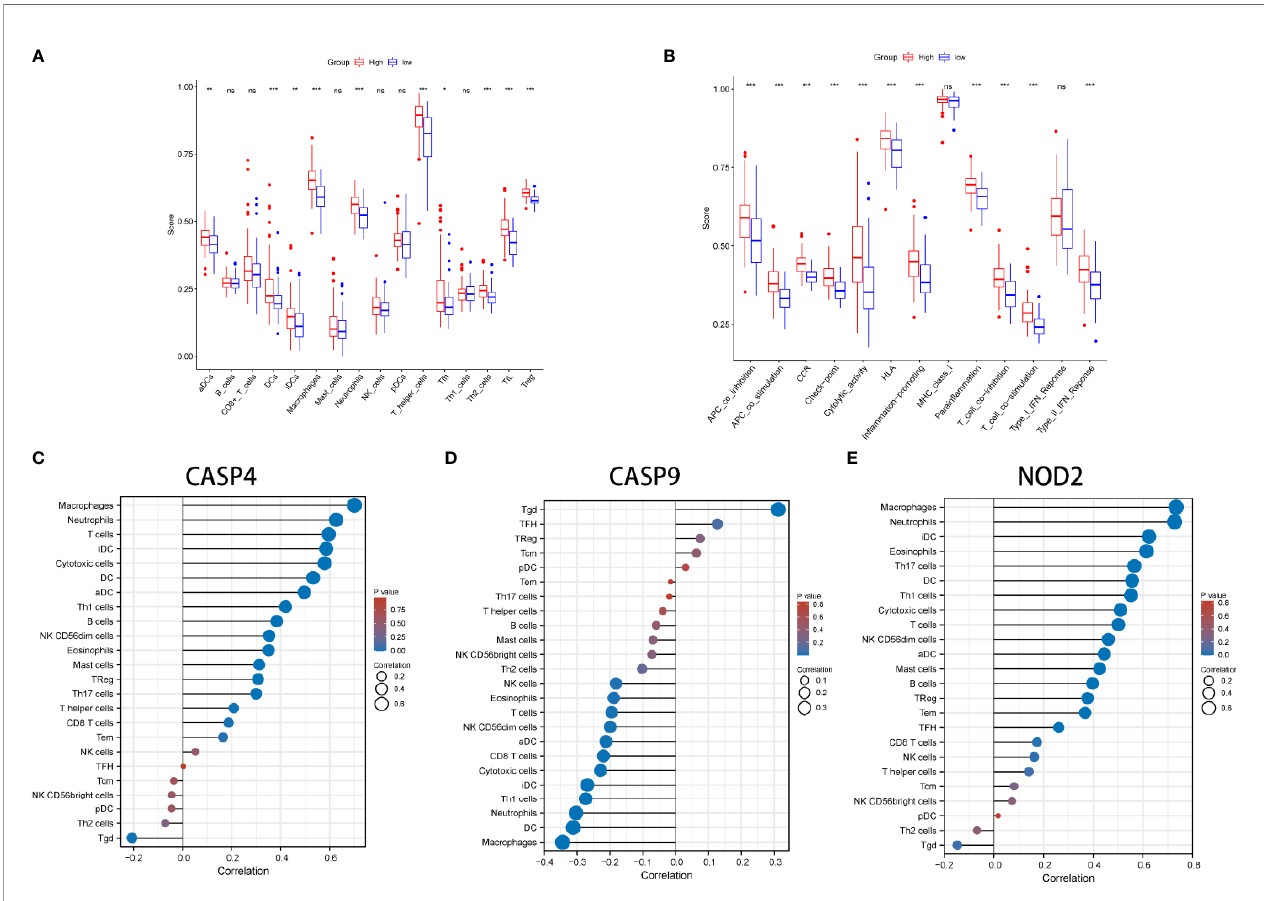
FIGURE 8 | Comparison of the ssGSEA scores between different risk groups in the derivation cohort. The scores of 16 immune cells (A) and 13 immune-related functions (B) are displayed in boxplots. (C – E) The correlation between in fi ltrating immune cell types in GBM and three DEGs. *P < 0.05; **P < 0.01; ***P < 0.001; ns p >